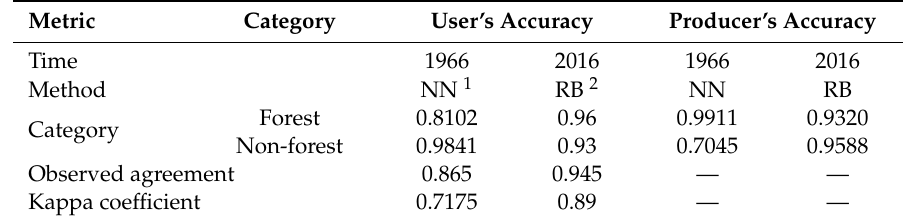
Table A1. The results of the accuracy assessment of forest and non-forest classification categories using aerial photos and Landsat images in NE,